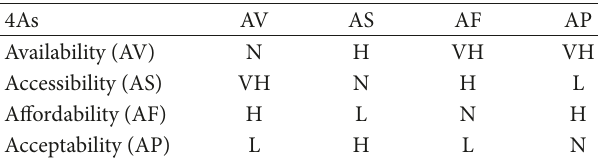
Table5:Direct-influencedrelationmatrixusinglinguisticvaluesfor